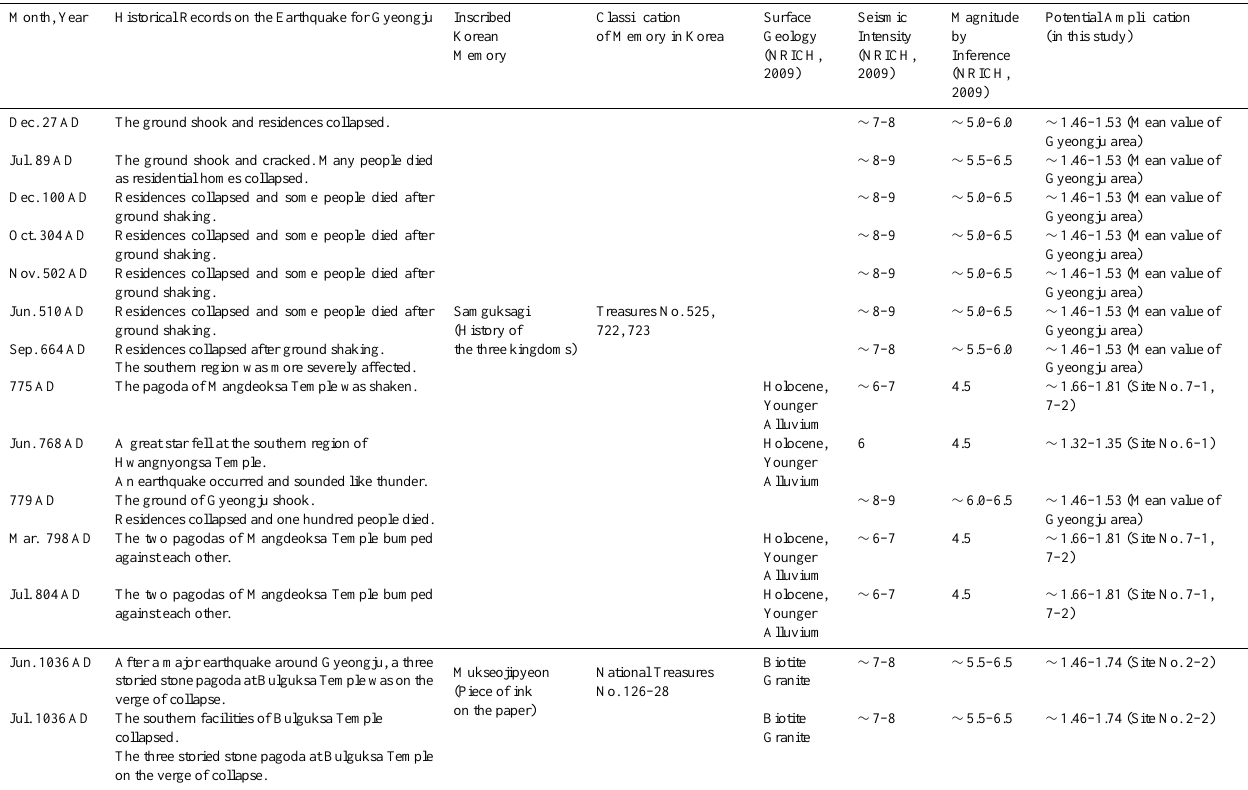
Potential Amplification (in this study)